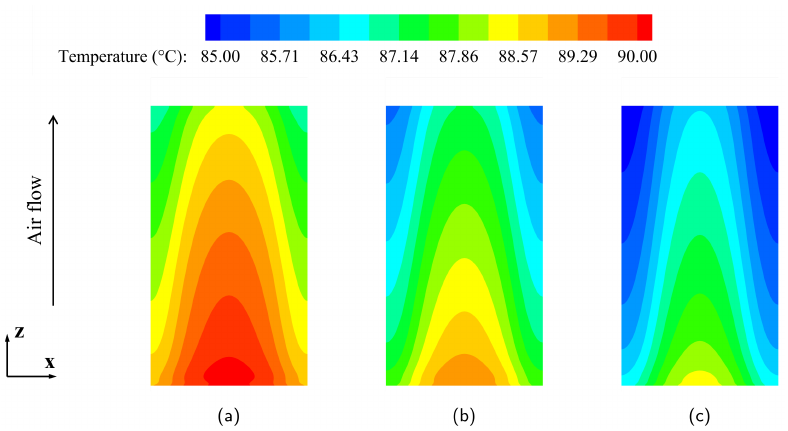
Figure 12. Impact of the LCWR on the temperature distribution over the middle plane of the CCL: